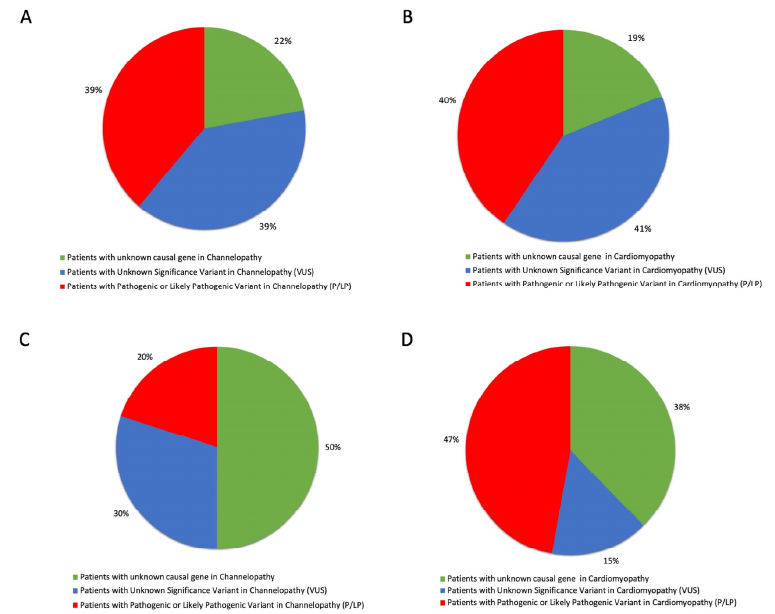
Figure 1. Percentage of channelopathy and cardiomyopathy patients carrying pathogenic/likely pathogenic (P/LP) and unknown significant (VUS) variants, as identified using ( A , B ) first-level and ( C , D ) extended panels. Variants were classified according to ACMG guideline classification with respect to patients without a known causative